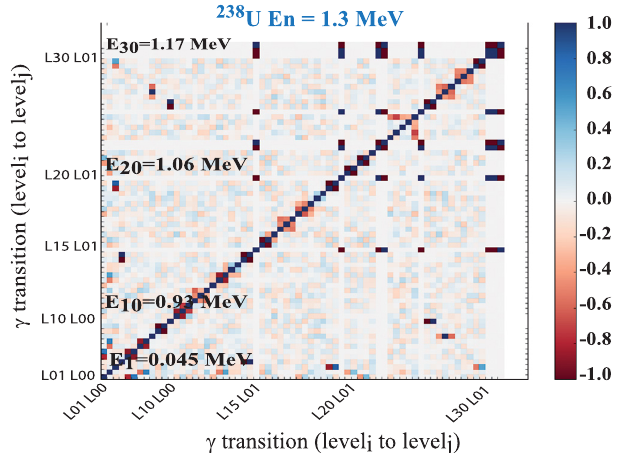
Fig. 8. Correlation matrix of g -transition cross sections in 238 U (n,n 0 ) reaction ( E =1.3MeV) obtained with TALYS-1.8 where nuclear structure of 238 U has been varied by Monte Carlo procedure. The g -transitions are refered to TALYS level numbering but the corresponding excitation energy is speci fi ed along the Y scale.